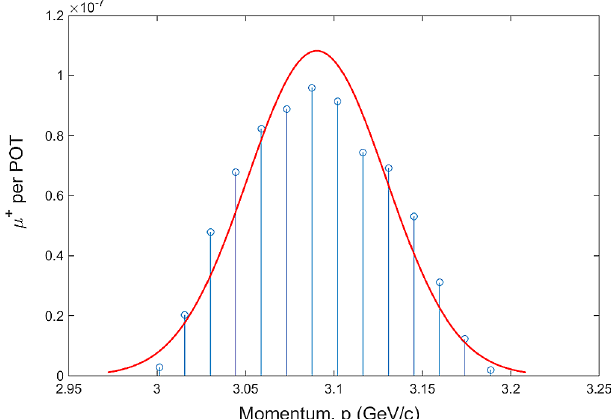
FIG. 8. The muon momentum distribution at the end of the Muon Campus, where the muons have an average momentum of 3 . 09 GeV =c with one standard deviation of 1.20%. The solid curve is a Gaussian distribution fit to the points.